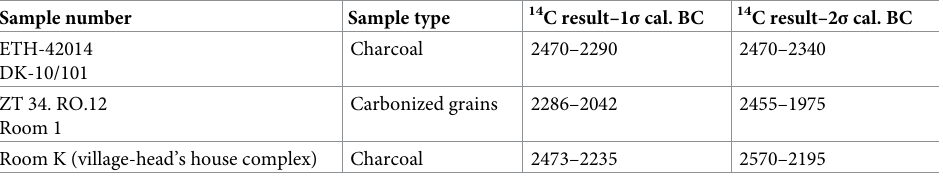
Table 1. Radiocarbon results of charcoal and carbonized grain samples from the Resulo ğ lu settlement. The analy- sis has been conducted at ETH Zurich and the Sarayko¨y Atomic Energy Institute in Ankara. Sample